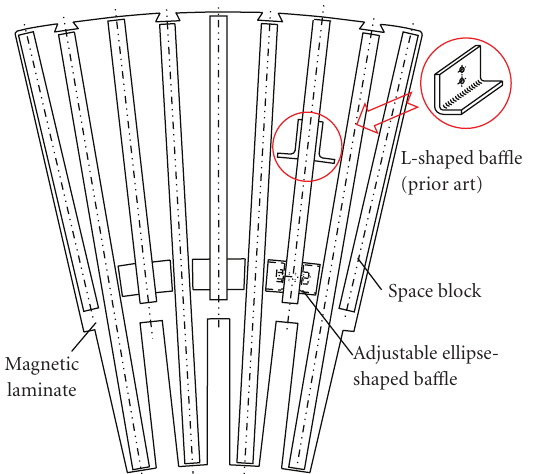
Figure 11: Assembly of adjustable ellipse-shaped ba ffl es on outside space block.